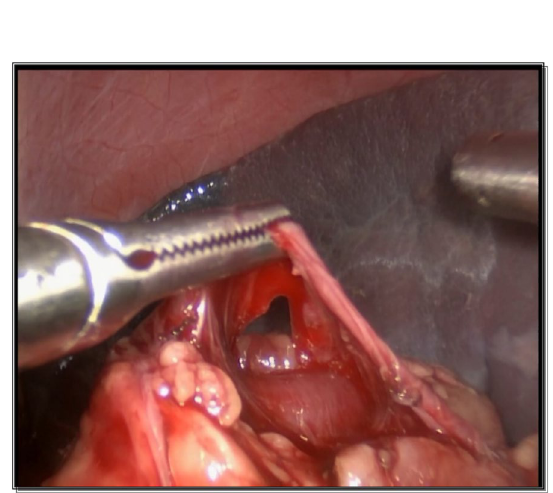
Fig. 2 Selective dissection of the